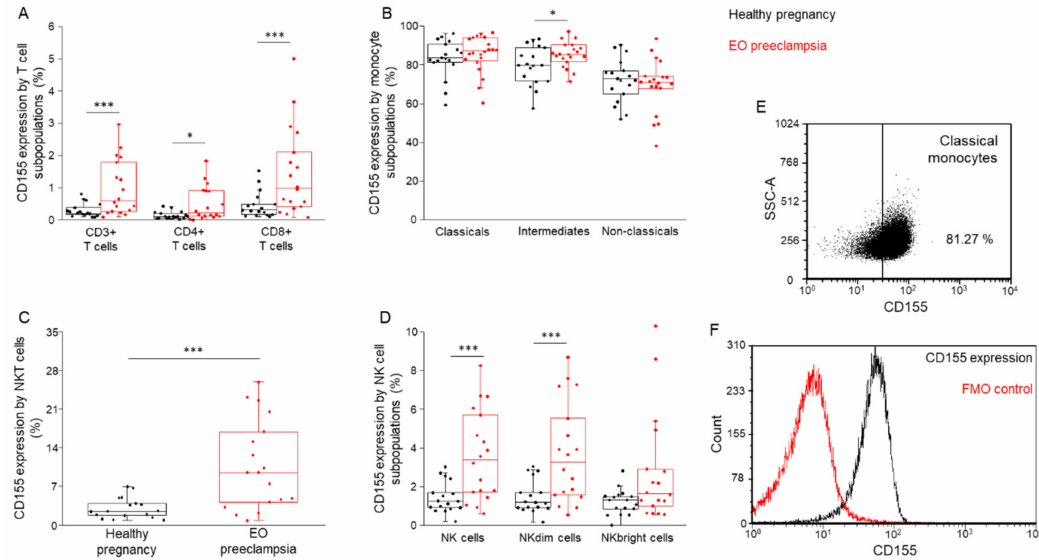
Figure 9. CD155 expression by the investigated immune cell subpopulations in women with EO preeclampsia and healthy pregnant women. The expression of CD155 by different monocyte ( A ), T cell ( B ), NKT cell ( C ), and NK cell ( D ) subpopulations in the peripheral blood of women with EO preeclampsia and healthy pregnant women. The solid bars represent medians of 17 and 20 determinations, respectively, the boxes indicate the interquartile ranges, and the lines show the most extreme observations. Differences were considered statistically significant for p -values < 0.05 *, p < 0.01 ***. Representative FACS plots show the expression of CD155 receptor by classical monocytes ( E ). To determine the positivity of the CD155 receptor, FMO control was used ( F